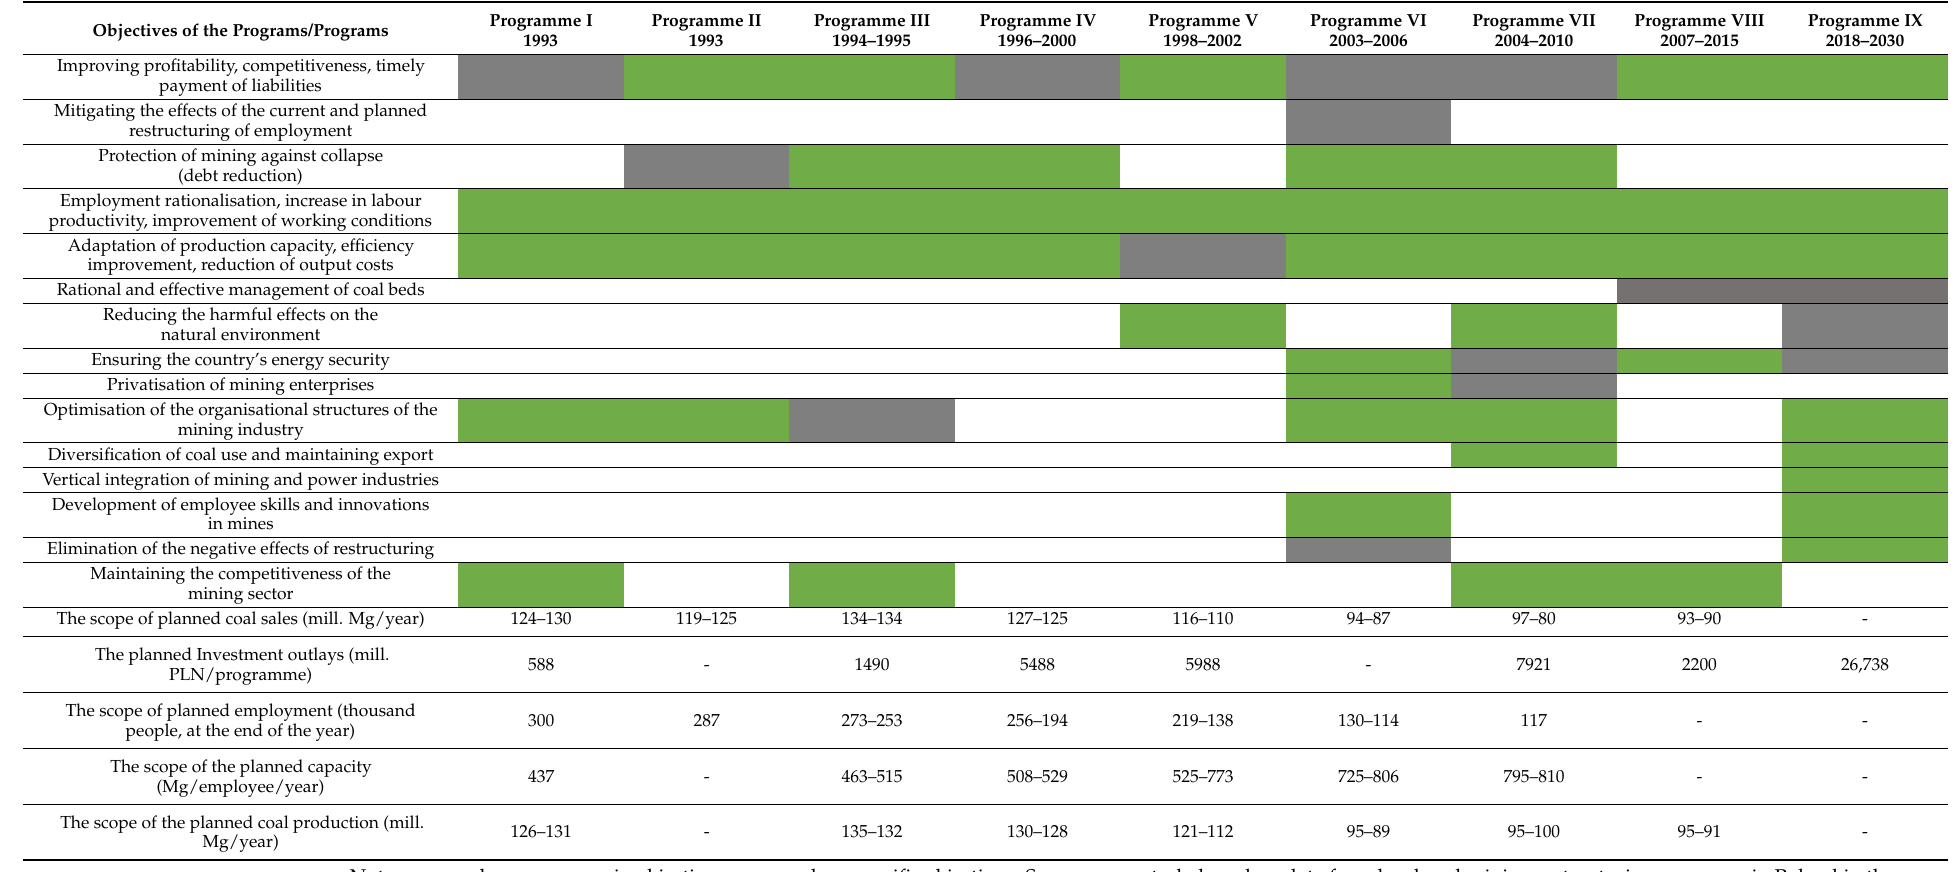
Table 2. Objectives and anticipated effects of the implementation of the hard coal mining restructuring programs in Poland in